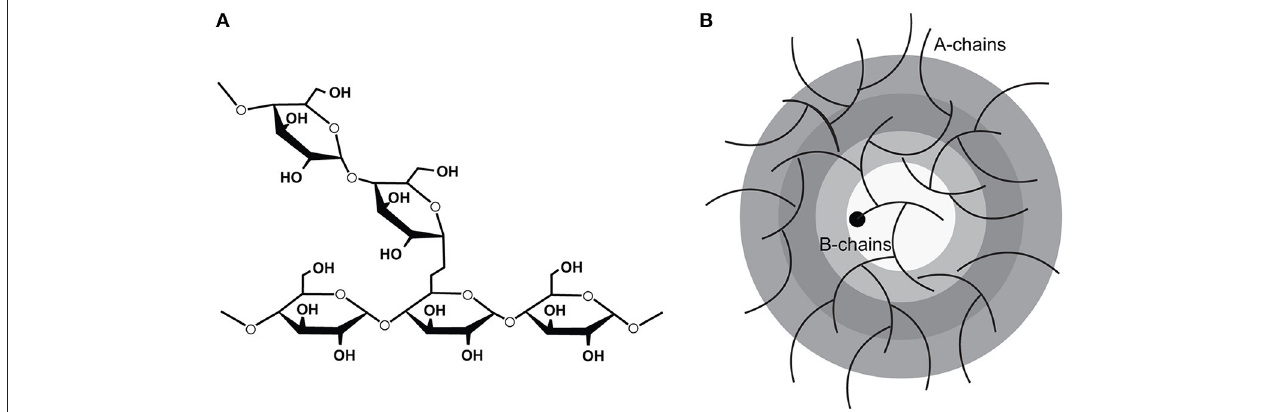
FIGURE 1 | The molecular structure of glycogen showing (A) the 1,4 linkages which polymerize the glucose moieties and the 1,6 linkages which confer the branch points and (B) the arrangement of the polymerized glucose into tiers. (Adapted from Roach et al.